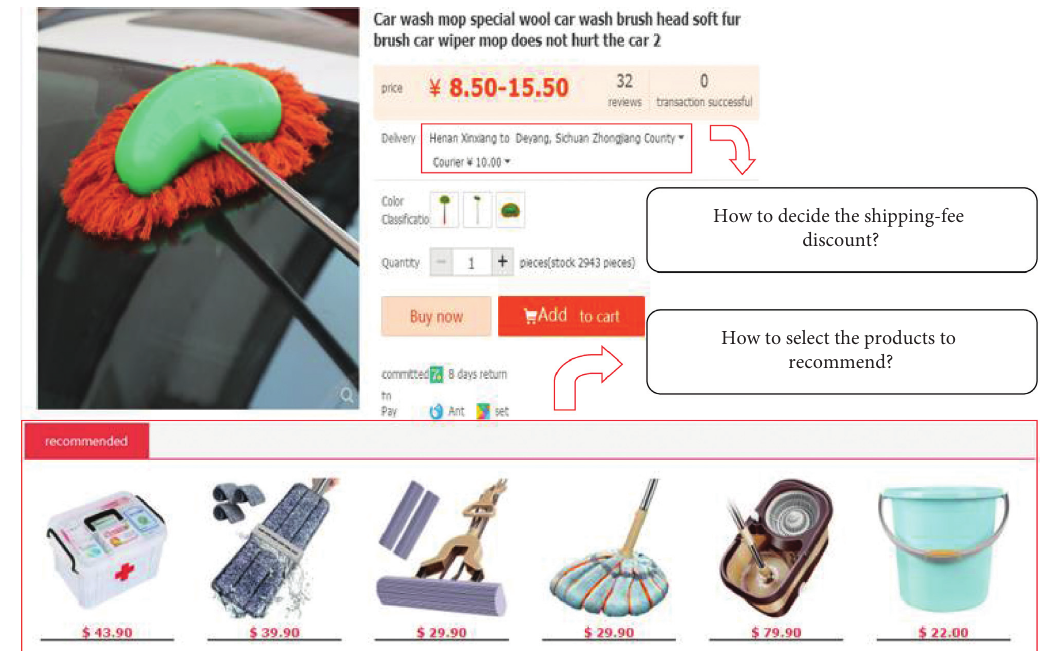
Figure 1: An example of the shipping fee and recommendation on